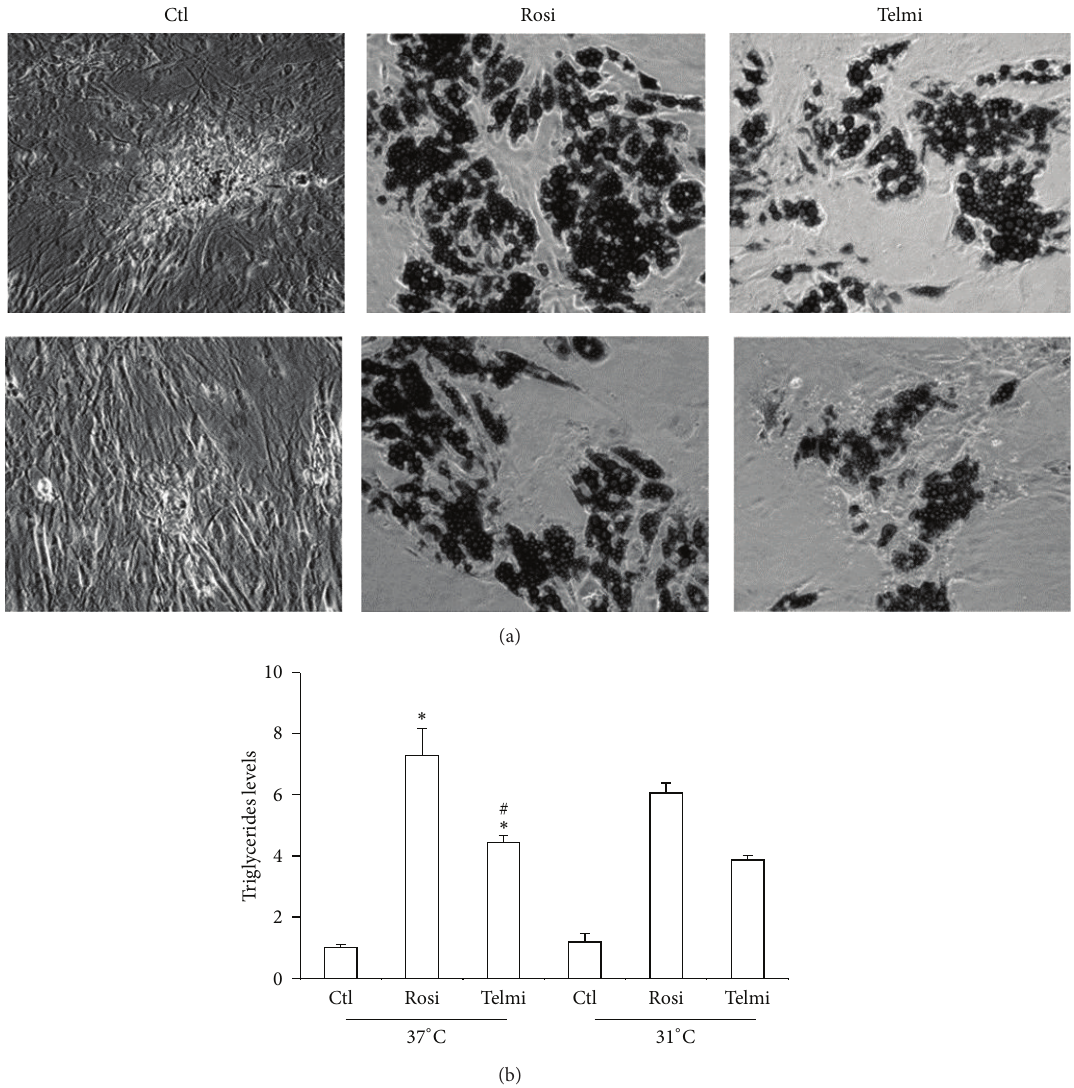
Figure 1: Effect of cold on triglyceride levels in differentiated human adipocytes. (a) ADMSCs were obtained from human subcutaneous adipocytes differentiated and induced for 10 days with 1 𝜇 M of full agonist (Rosiglitazone) and 50 𝜇 M partial agonist (Telmisartan). Cells were maintained at 37 ∘ C or exposed to 31 ∘ C for 4 hours and after, staining was performed with Oil Red O. (b) Quantification of triglyceride levels is expressed as relative values. Statistical analysis was performed using ANOVA test. Data are expressed as mean ± SD of 3 independent experiments performed in triplicate. Differences were considered statistically significant at 𝑃 < 0.05 . Rosi (Rosiglitazone), Telmi (Telmisartan). ∗ Differences between triglyceride levels of treatments with PPAR agonist in relation to control (induction of differentiation with basal medium). # indicates differences found between